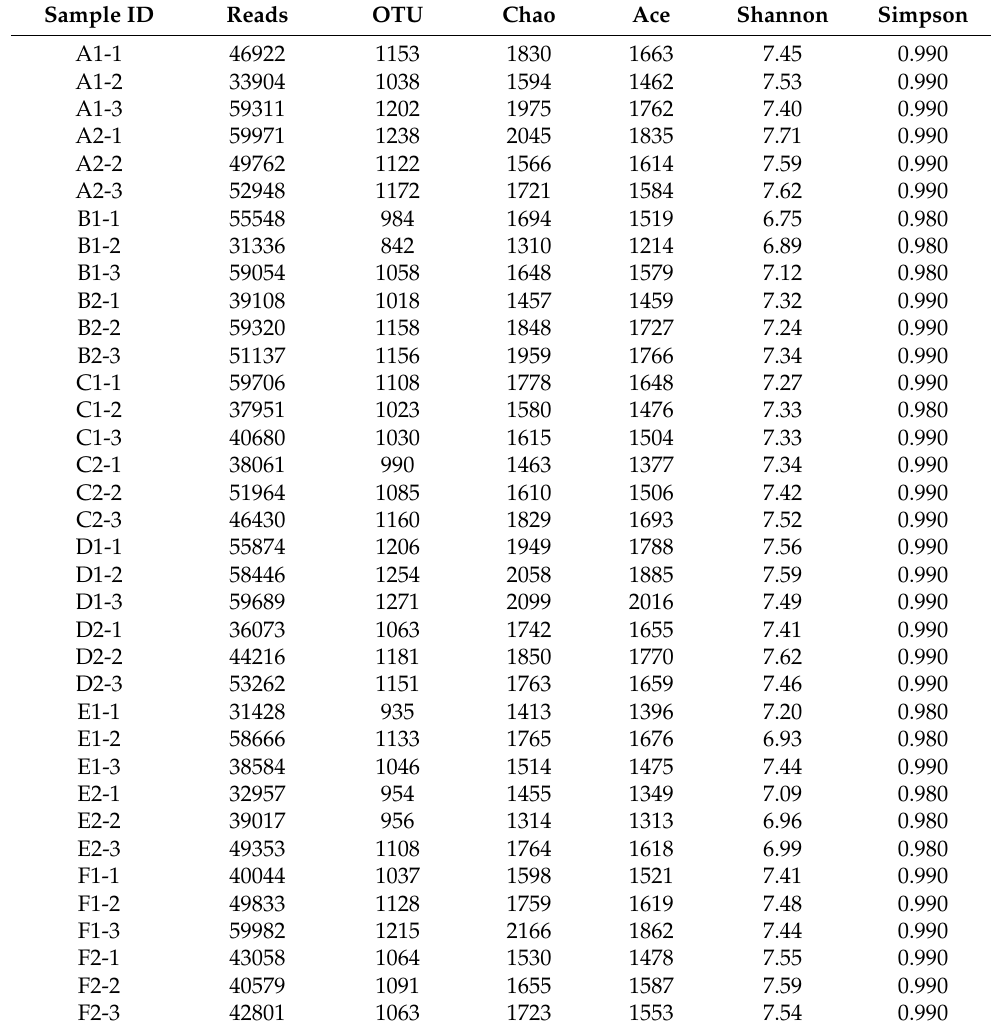
Table 5. Estimation of the diversity of the 16S rRNA gene information of the cecum from the sequence